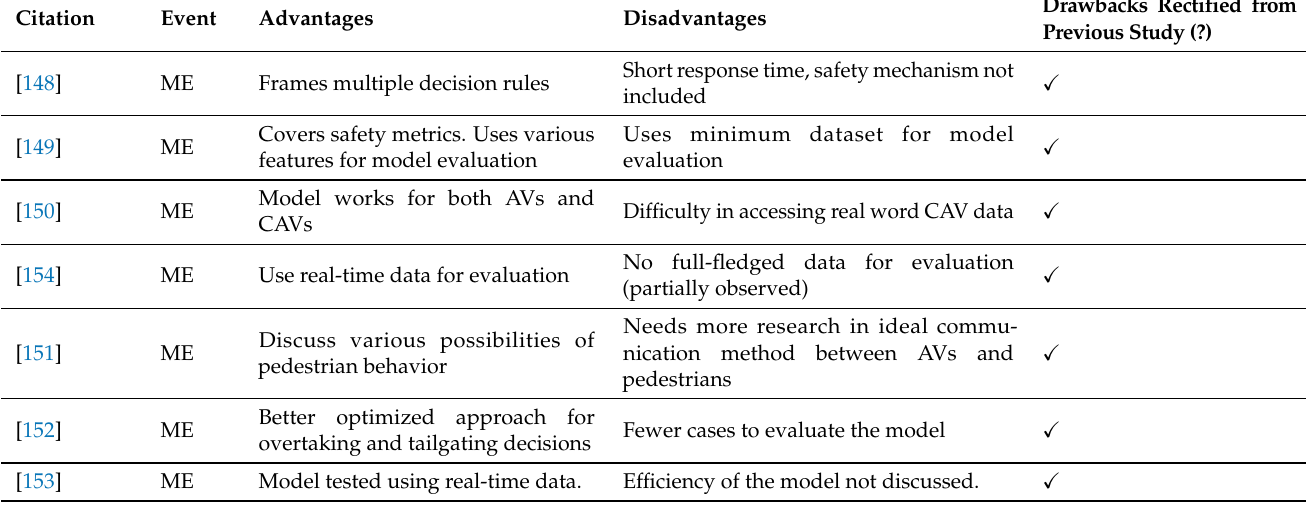
Table 8. Chronological summary of decision-making for multiple roadside events